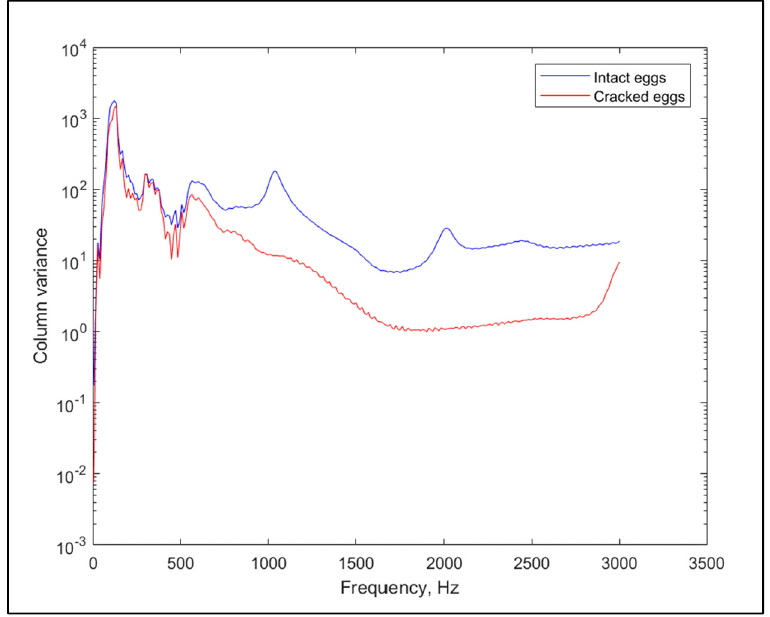
Figure 2. Column variances of the FFT coefficients for the two groups of samples.